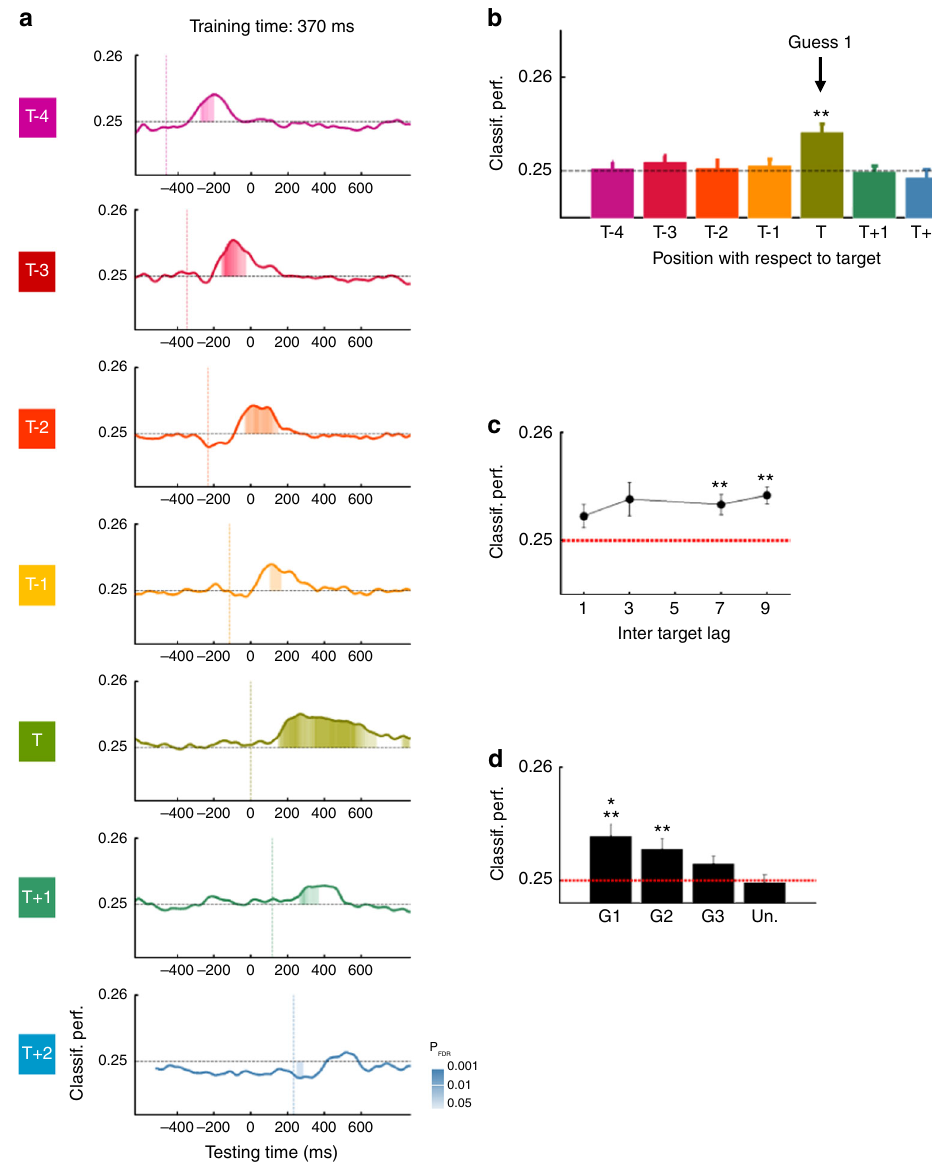
Fig. 5 Evidence for late discrete selection: Late brain responses are sustained only for reported stimuli. a Classi fi cation performance as a function of time for target stimulus and nearby distractors for a classi fi er trained at 370 ms (colors and statistics are as in Fig. 4b). Colored dotted lines represent stimuli onsets. b Mean classi fi cation accuracy over a time period of 400 – 550ms (as in Fig. 4c). c Effect of inter-target lag. Classi fi cation performance averaged over Guess 1 and 2 and over time (400 – 550 ms) as a function of inter-target lag. d Effect of report. Mean classi fi cation performance between 400 and 550 ms for stimuli reported as Guess 1, 2, 3, and unreported stimuli. The red dotted line represents chance. Asterisks represent results from signed rank tests (* P < 0.05; ** P < 0.01; *** P < 0.001, FDR corrected across conditions). For display purposes, data points were smoothed using a moving average